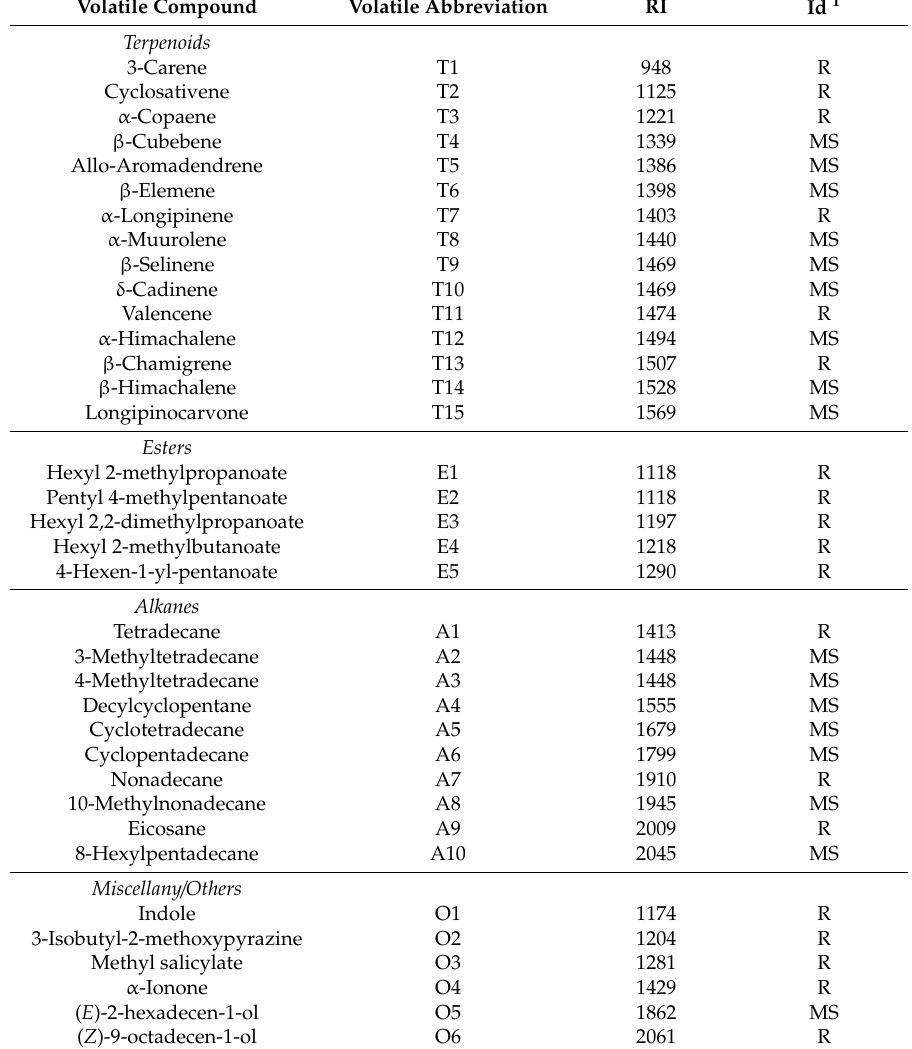
Table 2. The list of volatiles identified from Capsicum accessions / hybrids with their corresponding volatile abbreviation, retention index (RI), and identification method